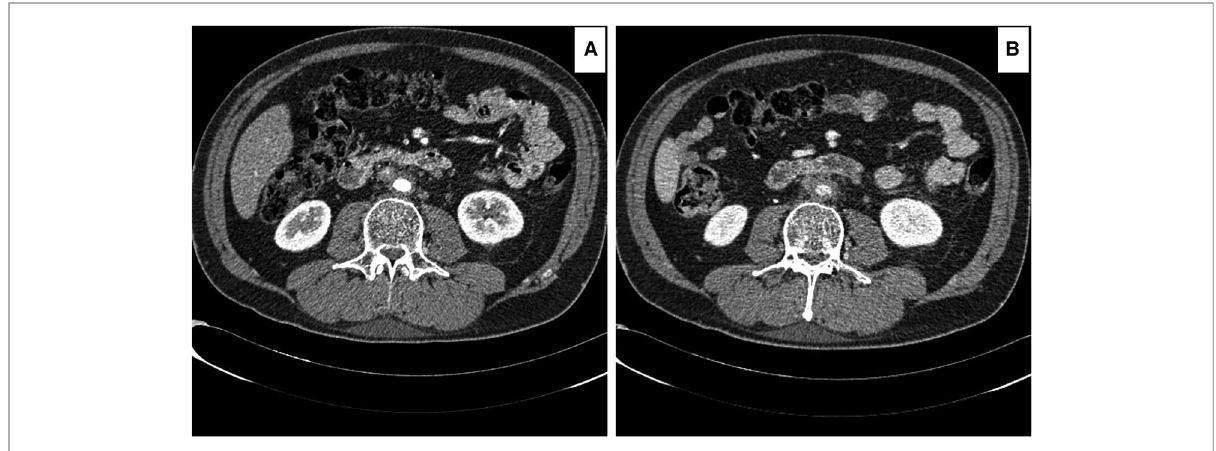
FIGURE 1 Computed tomography angiography (CTA) images showing worsening of the peri-aortic soft tissue after medical management. ( A ) RPF with less than 3 mm enhancements around the aorta and 21 mm aortic diameter. ( B ) after six months of steroid and mycophenolate, the enhancements increased to 5 mm, and the aortic diameter decreased to 18 mm. The patient had continuous abdominal and low back pain, not responding to the WHO one and two pain ladder medications.